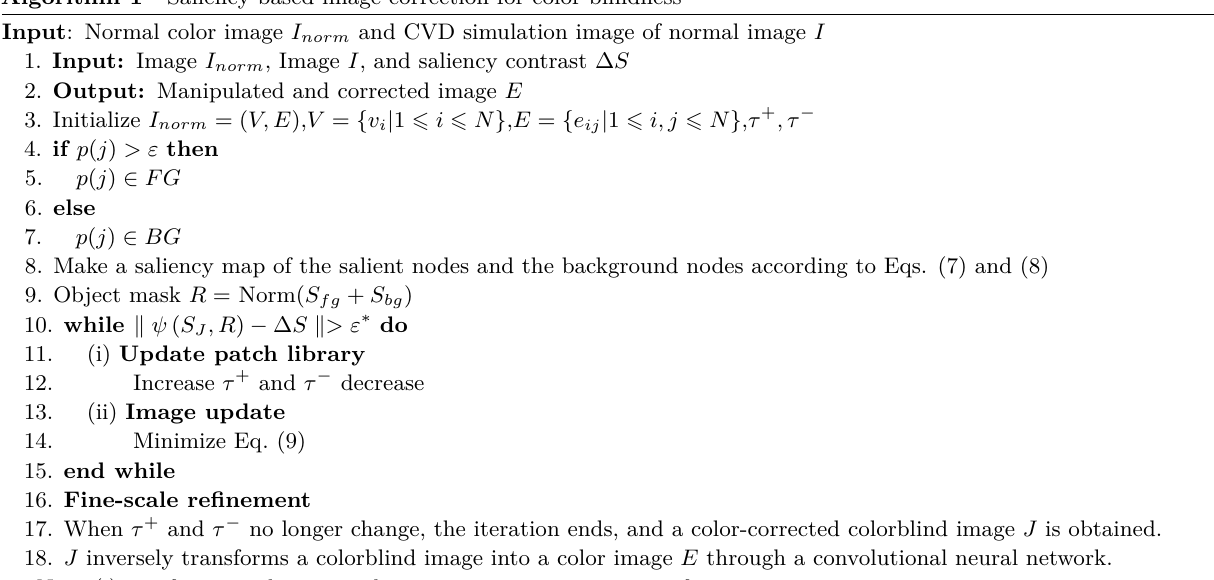
Algorithm 1 Saliency-based image correction for color